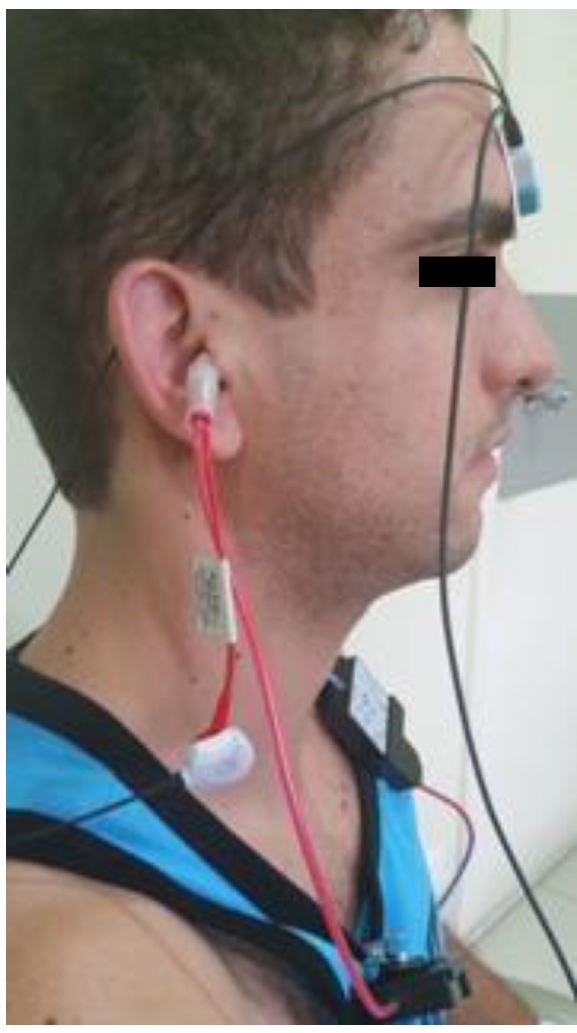
Figure 2 EcochG performed in the right ear.